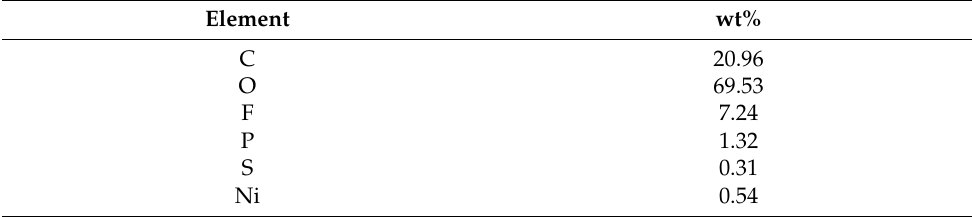
Figure 8. ( a – c ) SEM micrographs with different magnifications obtained from the NCM electrode of a -type NCM811 battery after 130 cycles. ( d ) The EDS diagram of the marked part from ( c ). Table 3. The element content obtained from the EDS at the marked negative position in Figure